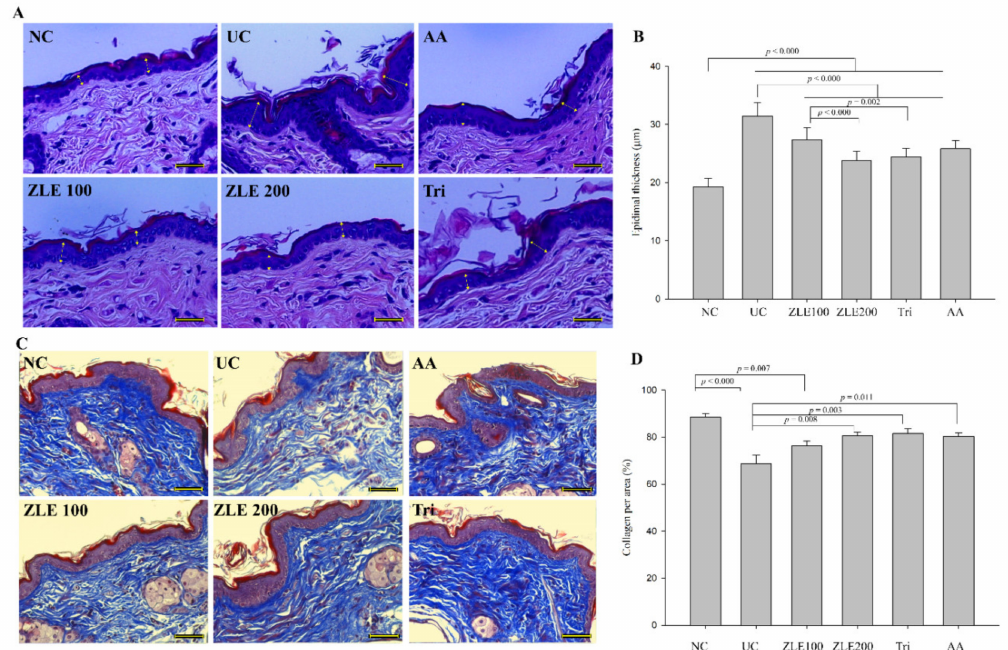
Figure 9. E ff ects of enzyme-treated Z. latifolia extract (ZLE) and tricin on the reduction in epidermal thickness and accumulation of collagen fiber in UVA-irradiated mice. The skin sections were stained using H&E staining or Masson’s trichrome staining. ( A ): Photographs of representative H&E stained skin sections. ( B ): Thickness of mice skin epidermis. ( C ): Representative Masson’s trichrome stained skin sections. ( D ): Quantification of collagen-positive pixels (blue color). The scale bar, located on the lower right of each image, is 0.1 mm and the images were obtained at 200 × magnification. Data are expressed as the mean ± SE. The p values are determined by ANOVA and Tukey’s HSD